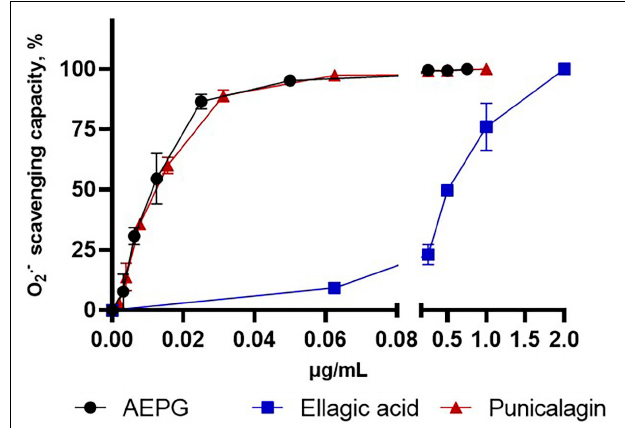
( Figure 7C ) and precipitated solids ( Figure 7B ) as PNCG and EA,